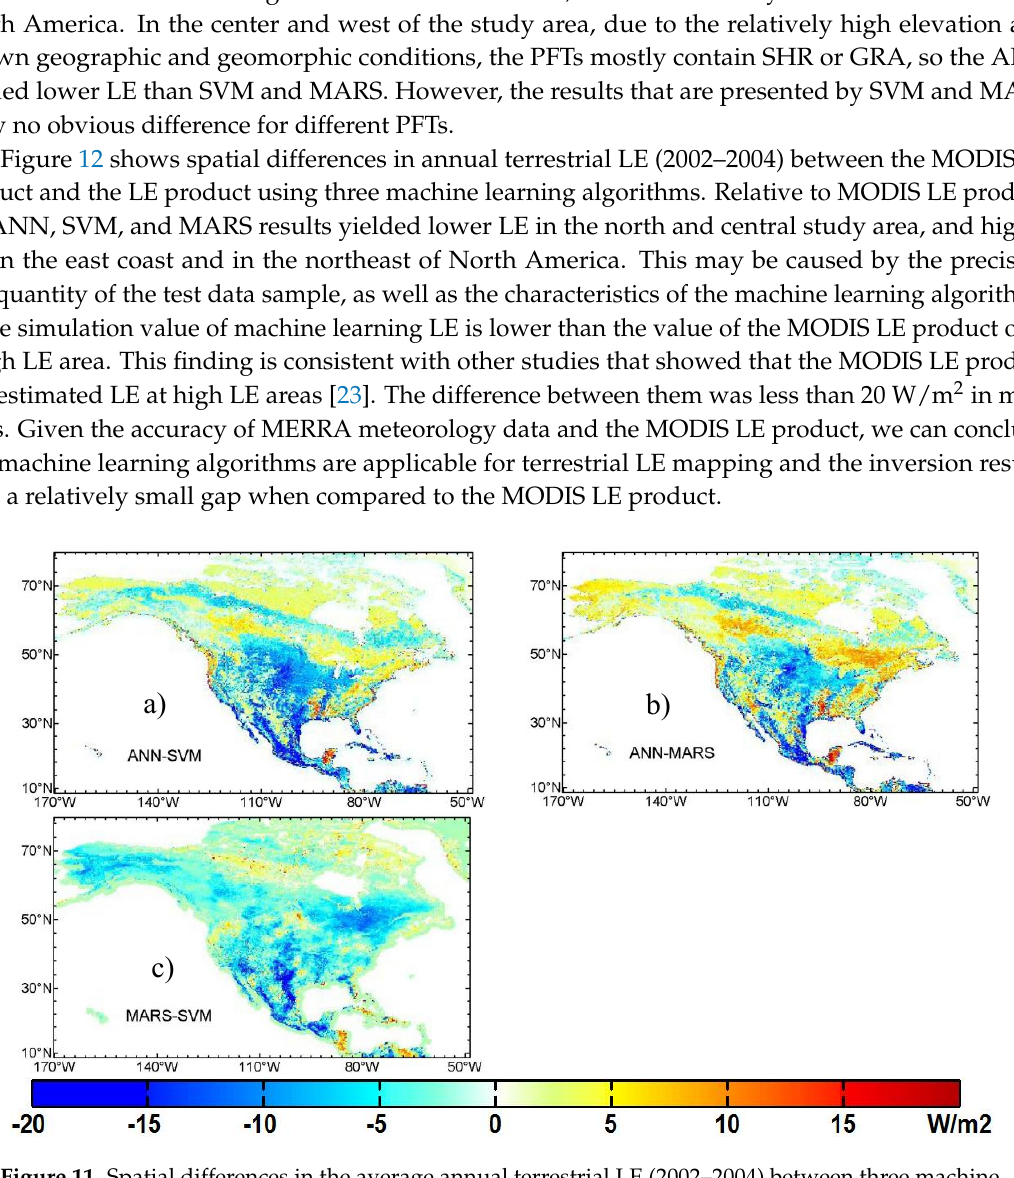
Figure 12. Spatial differences in the average annual terrestrial LE (2002–2004) between MODIS LE product and LE product using three machine learning algorithms. 4.3. Limitations and Recommendations for Future Research Although the ANN leads to better performance when compared to other machine learning algorithms, it has several limitations. First, ANN requires a relatively long processing time to train a model, especially for ENF and GRA, the input data of which are inaccurate, and thus require more